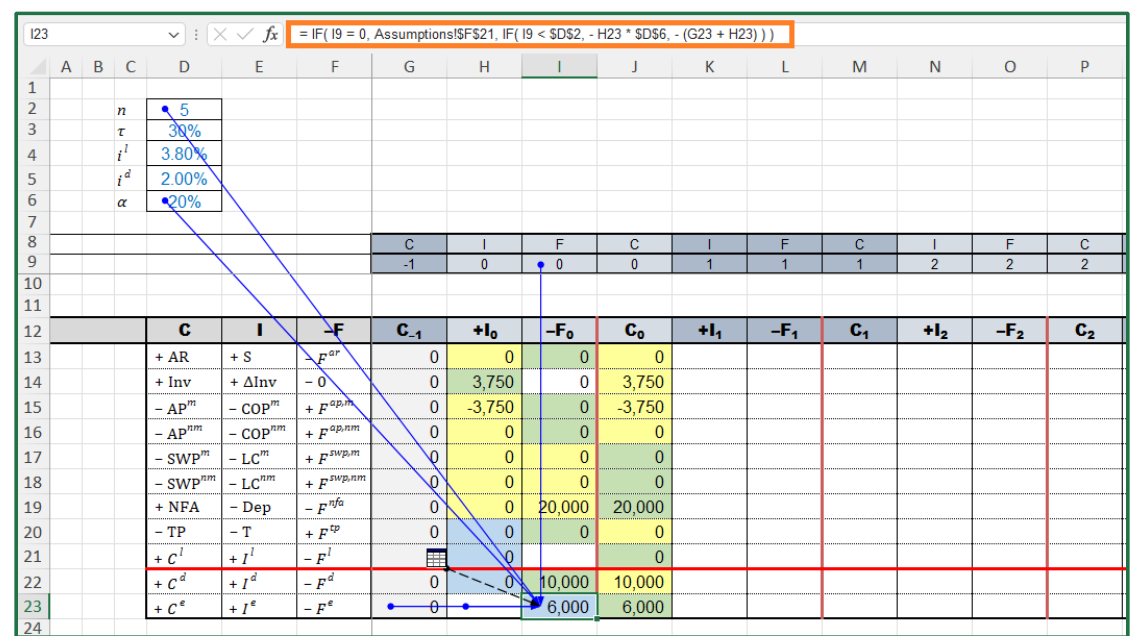
Figure 19. Cell I23 reports the cash flow to equity (“SplitScreenStrip” sheet). (The cells whose values are provided in “PreCalc” are in yellow, the cells whose values are calculated with the law of motion are in green, and the cells whose values are calculated via suitable formulas are in blue.)